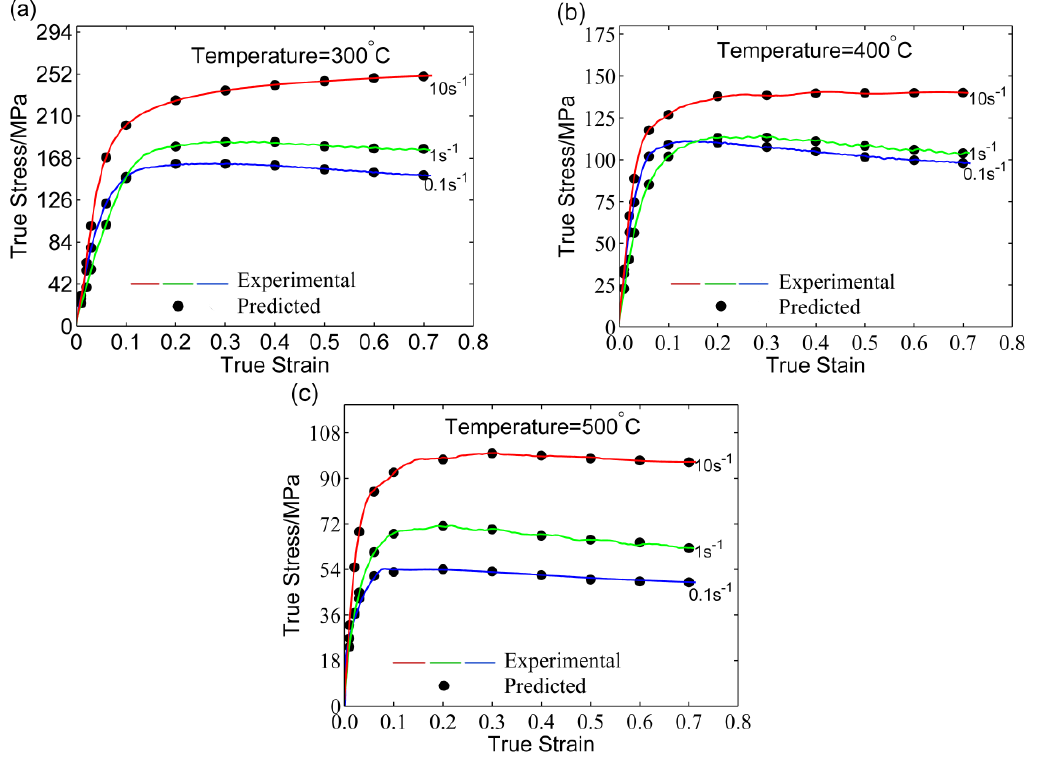
Figure 11. Comparison between the original and calculated stress data by ANN–GA at ( a ) 300 °C, ( b ) 400 °C and ( c ) 500 °C.